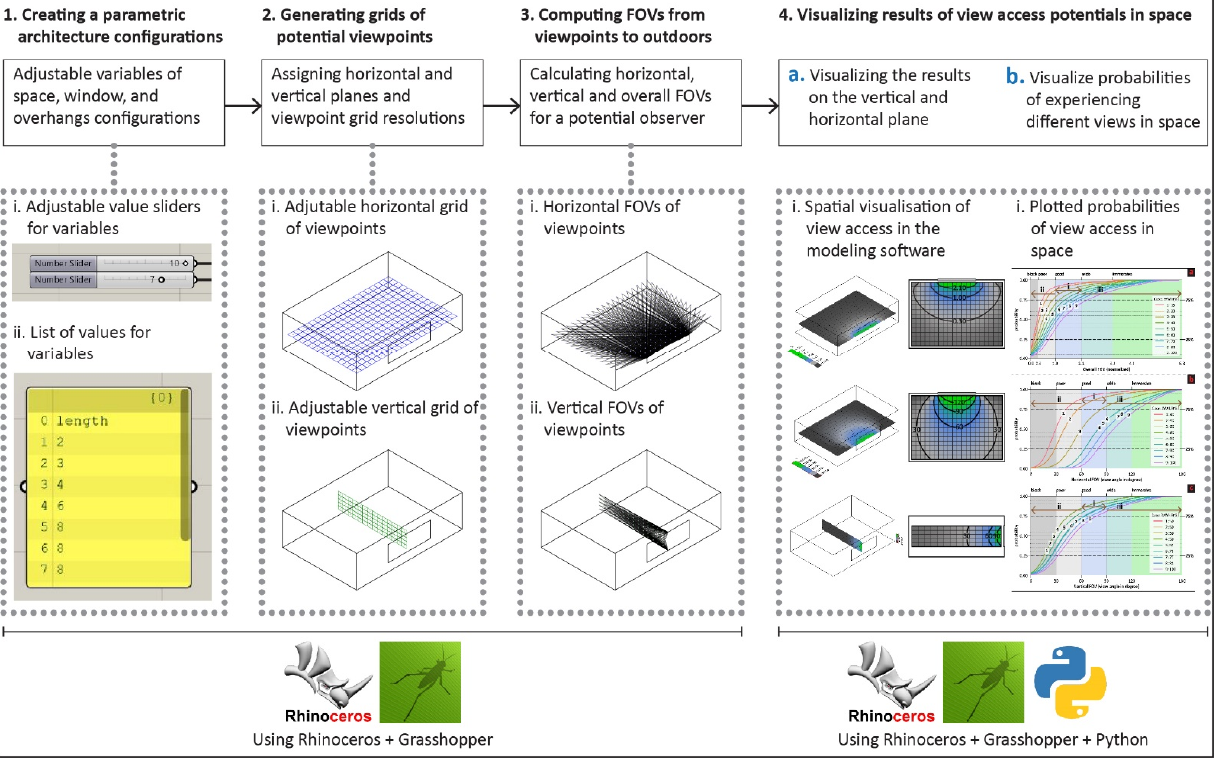
Figure 5. The configuration of horizontal and vertical grids and viewpoints in the pilot study with examples of view access towards windows for potential seated and standing observers (all dimen- sions are given in cm).